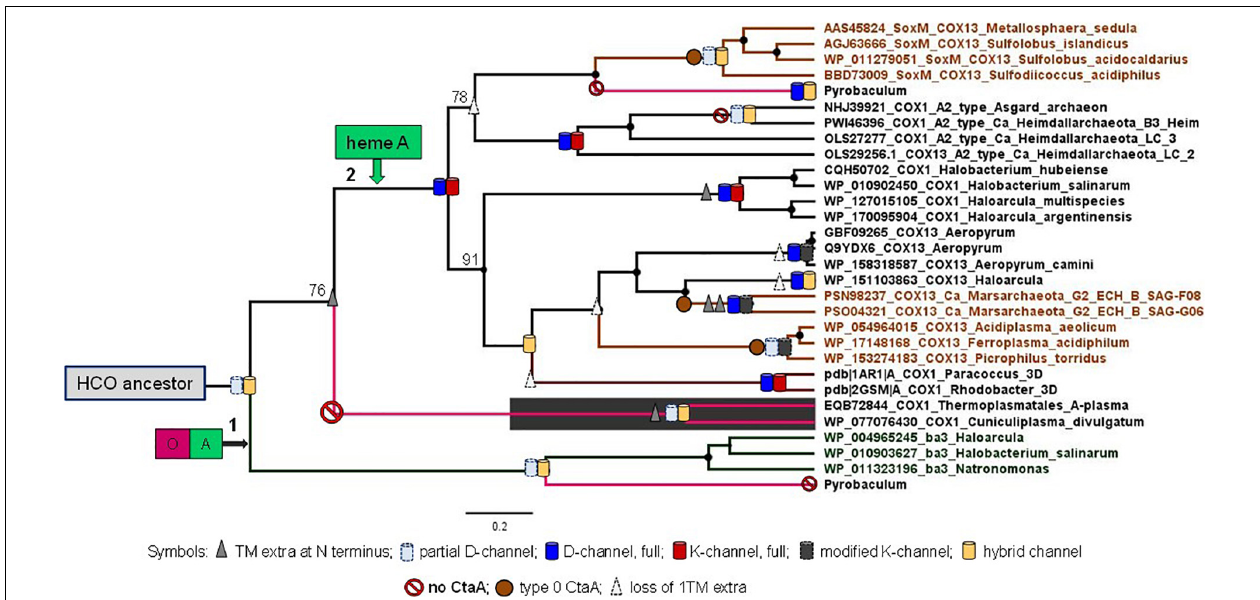
FIGURE 5 | Phylogeny of archaeal COX1. Bayesian MCC tree obtained with the BEAST package using an alignment of 28 archaeal COX1 sequences of both the family A and B and two bacterial COX1 from Rhodobacteraceae with known 3D structure as described in the Supplementary Material . The final alignment included 558 amino acid sites. Posterior branch support was 100% except for the three cases where numerals are shown adjacent to specific nodes. The distribution of an extra TM at the N terminal end and of the different variants of the K-channel classified in Supplementary Figure 7 , as well as of the D-channel (Degli Esposti et al., 2020), were annotated onto the tree branches using the symbols shown at the bottom of the